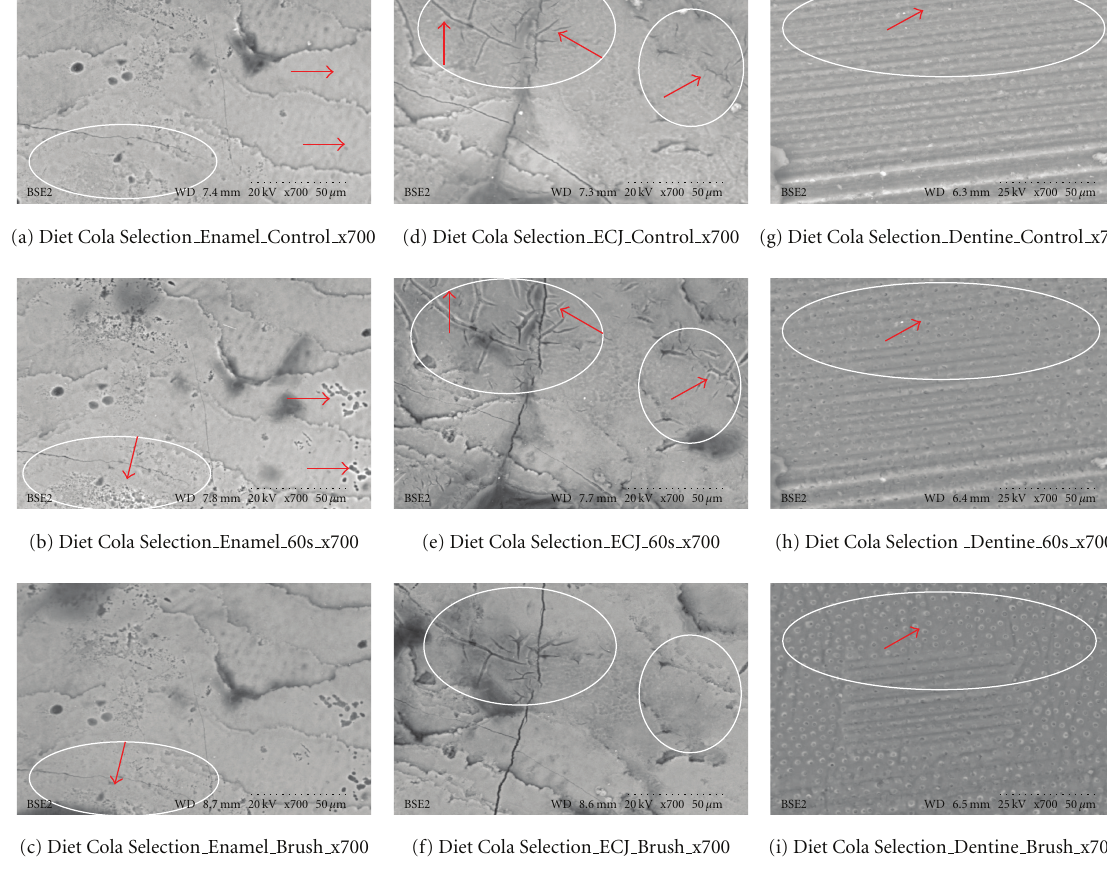
Figure 11: Diet Cola Selection ( × 700). White outlined areas clearly show erosion with surface crenellations and profusion of shrinkage cracks from calcium loss when comparing (a), (d), and (g) to (b), (e), and (h). Minimal abrasion is present on the enamel, but loss (red arrows) from brush abrasion is clearly visible in (f); the surface cracks while enlarged from erosion, appear narrower and less numerous, as the soft superficial material is lost to abrasion. Red arrows, (g)–(i), show that dentine tubules exposed from erosion appear clearer, wider, and more open as the soft surface material is lost to brush abrasion. These SEM results are also consistent with the calcium dissolution from swishes in Figure